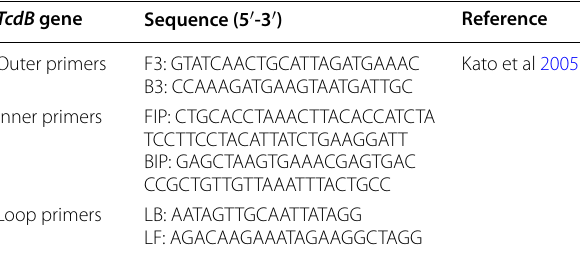
Table 2 The sequences of special primers for the LAMP